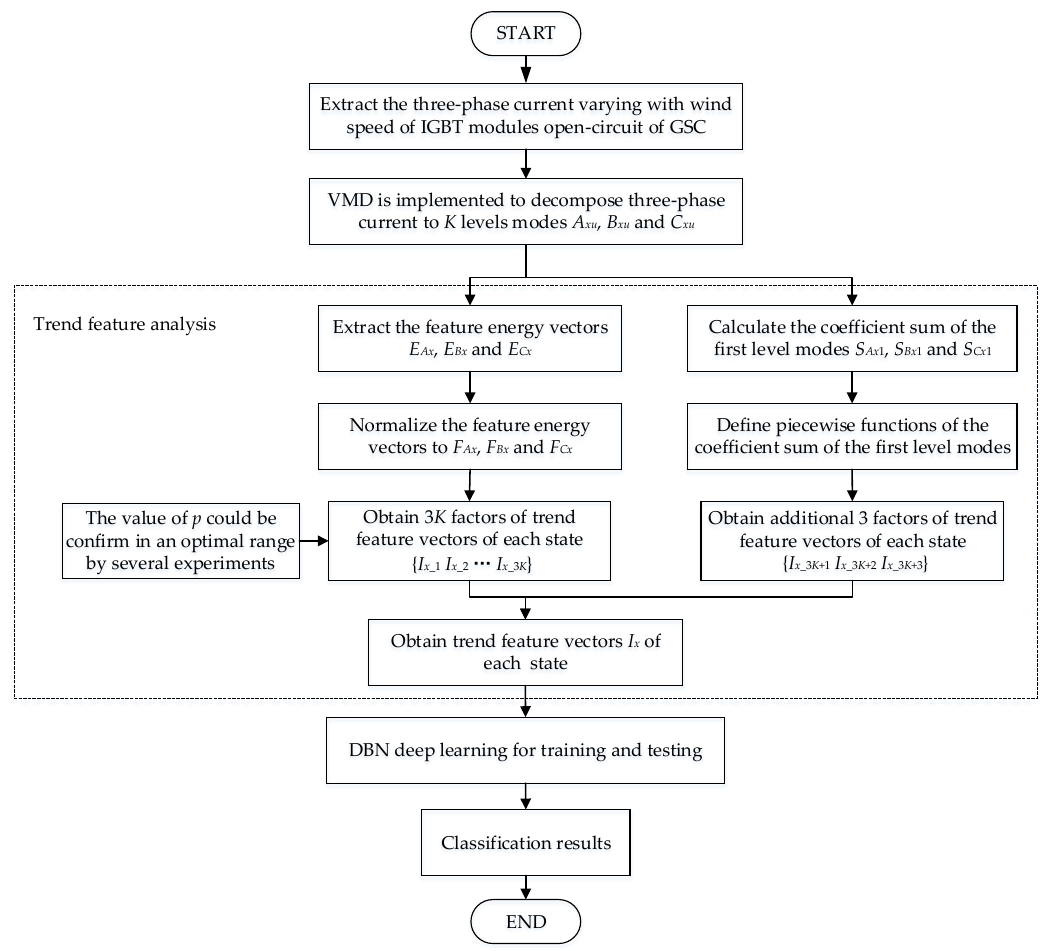
Figure 3. The mission profile of open-circuit fault diagnosis with proposed novel method.